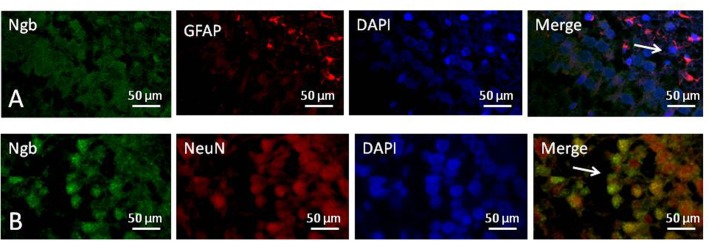
Location of neuroglobin Detection of neuroglobin (Ngb) by immunofluorescence double staining in the hippocampus of the neonatal rat brain 18 h after anesthesia in group H. GFAP (red) co-localized with Ngb (green) shown in (A) and NeuN (red) co-localized with Ngb (green) shown in (B). Scale bar = 50 μm.